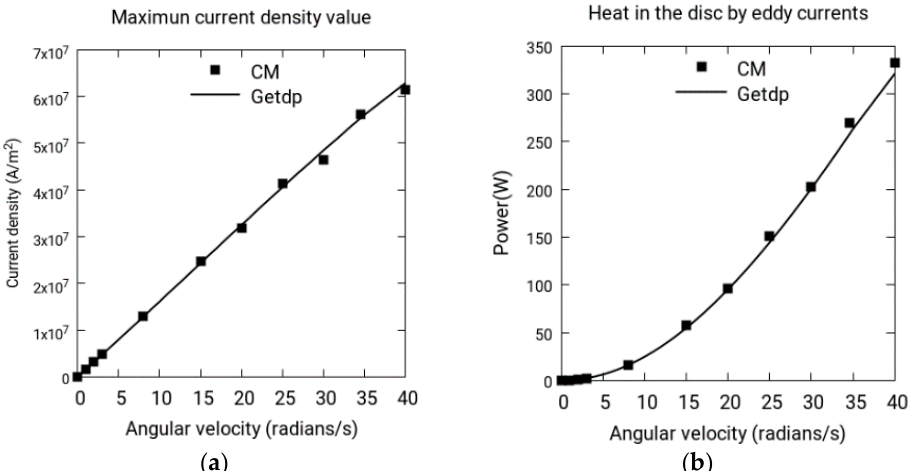
Figure 4. ( a ) Maximum current density in the disk, CM vs. Getdp; ( b ) the heat dissipated in the disk, CM vs. Getdp.